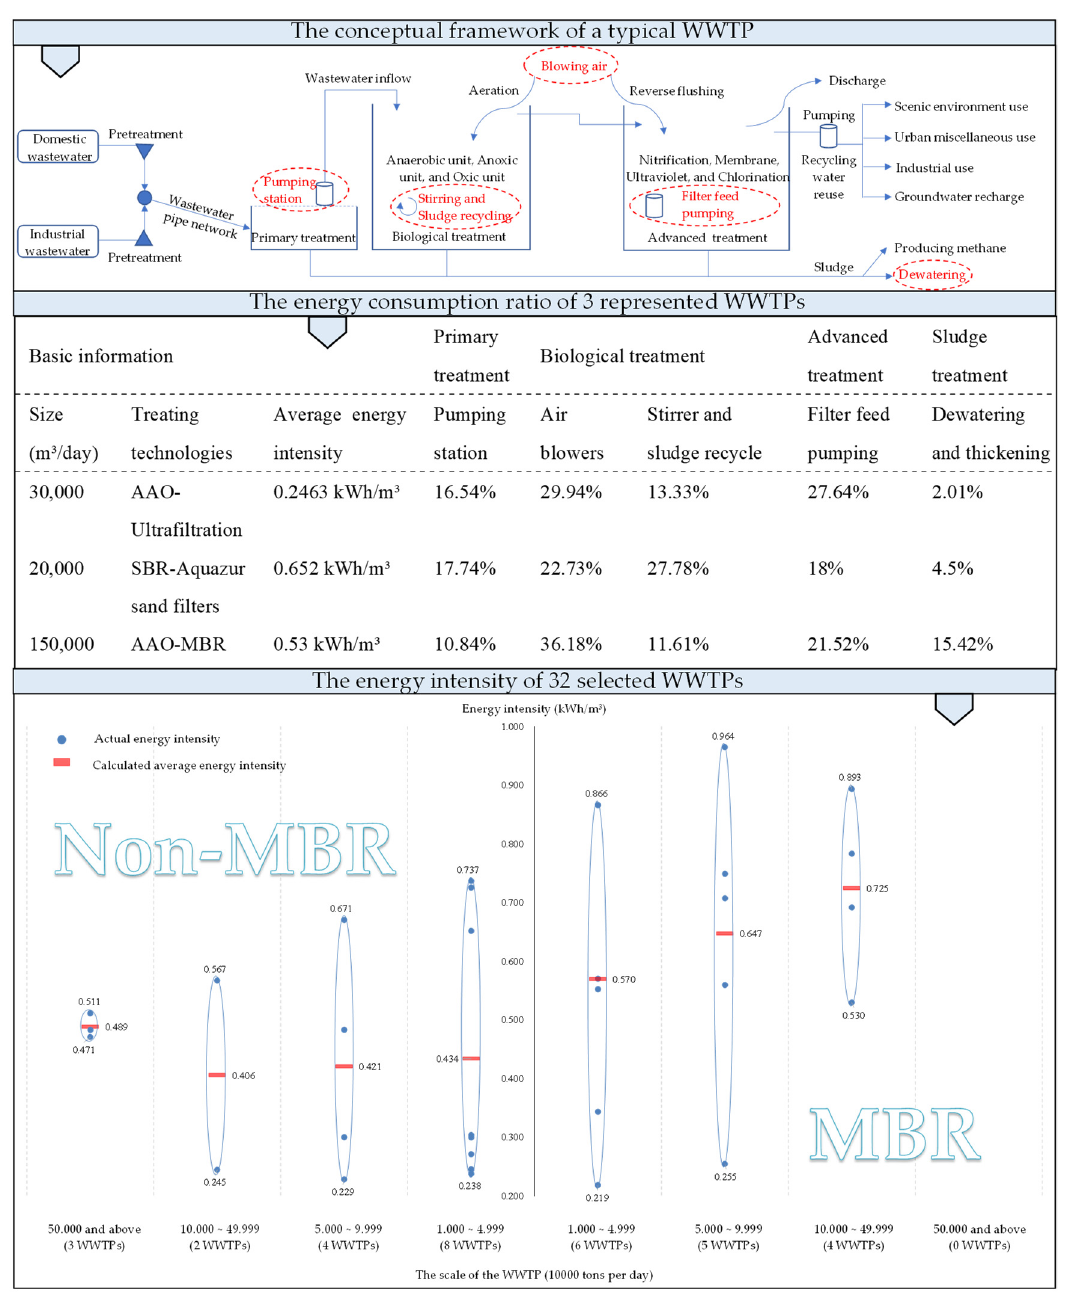
Figure 3. Holistic analysis framework for WWTPs in Beijing. Data sources: Urban Drainage Statistical Yearbook (2018) , [36,37,38].